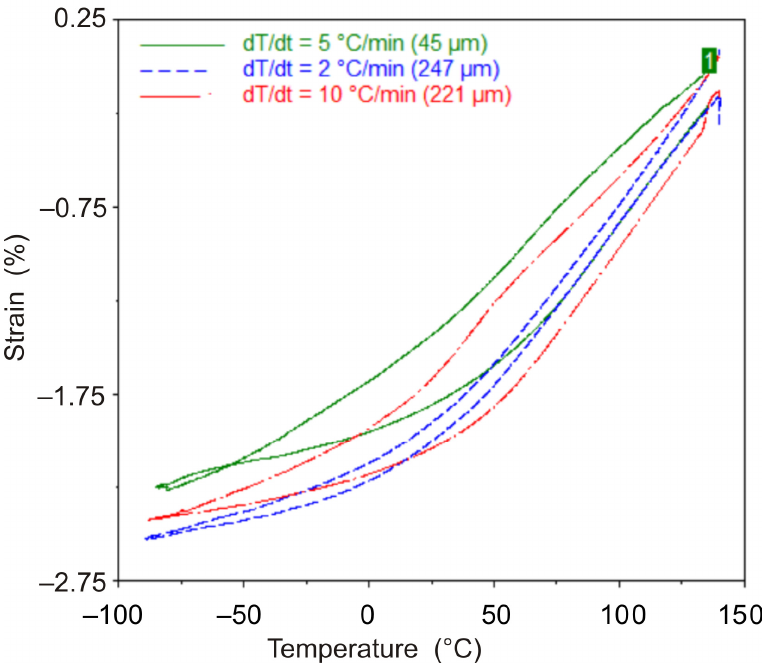
Figure 10. Dependence of strain on temperature for DeSolite DS-2015 polymer specimens with different thicknesses and cooling/heating rates: 45 μ m, 5 °C/min (green); 221 μ m, 10 °C/min (red); 247 μ m, 2 °C/min (blue).